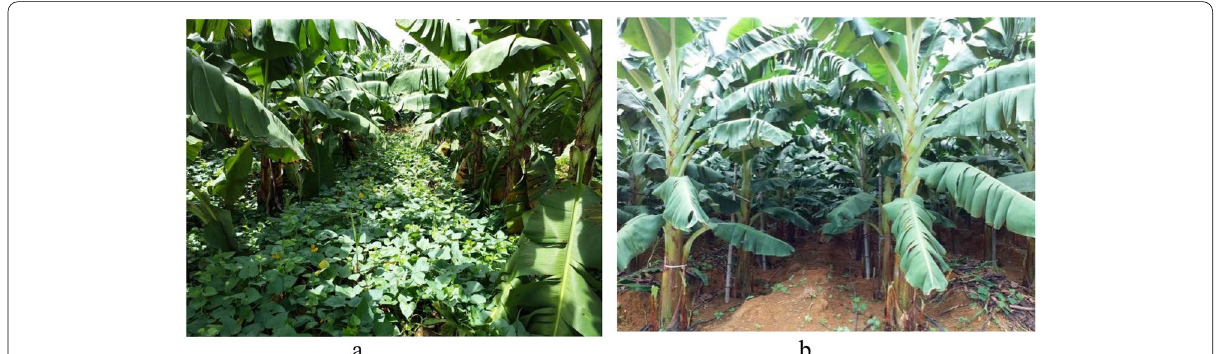
Fig. 1 Field picture of banana plantation treated in the experiment. a